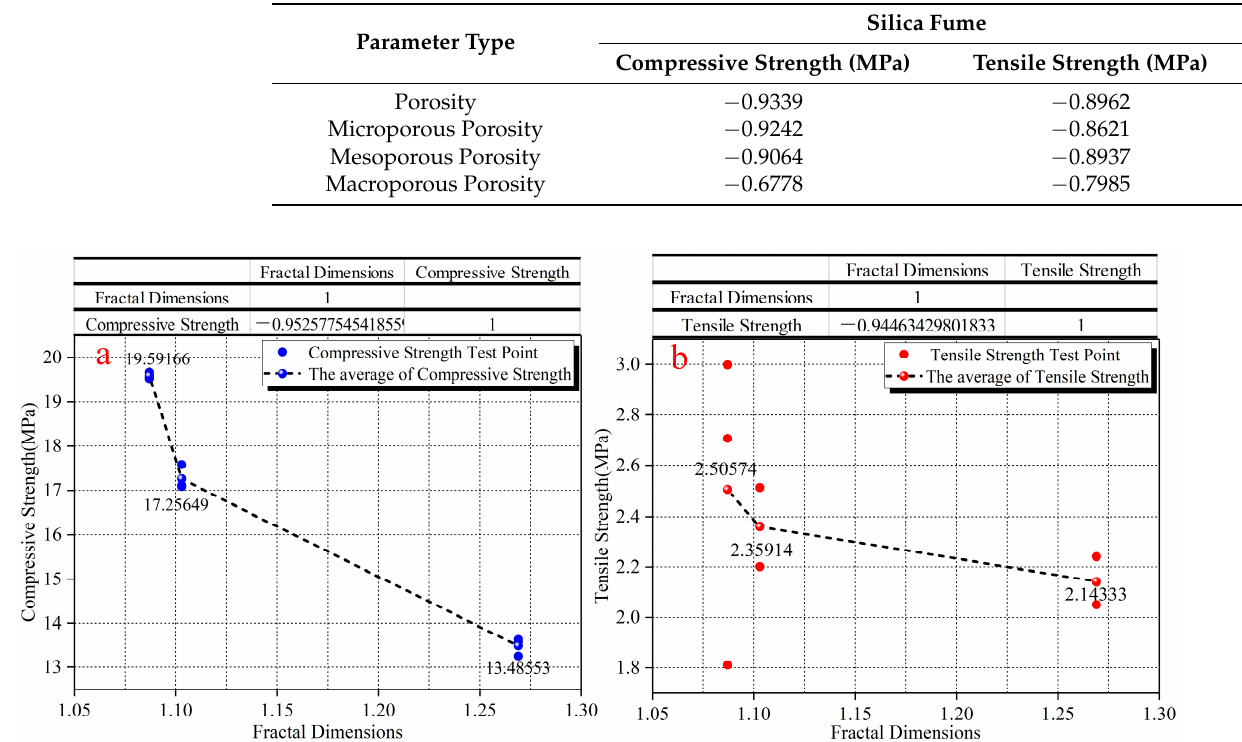
Figure 8. The influence of fractal dimension on compressive strength and tensile strength. ( a ) is the influence of fractal dimension on compressive strength. ( b ) is the influence